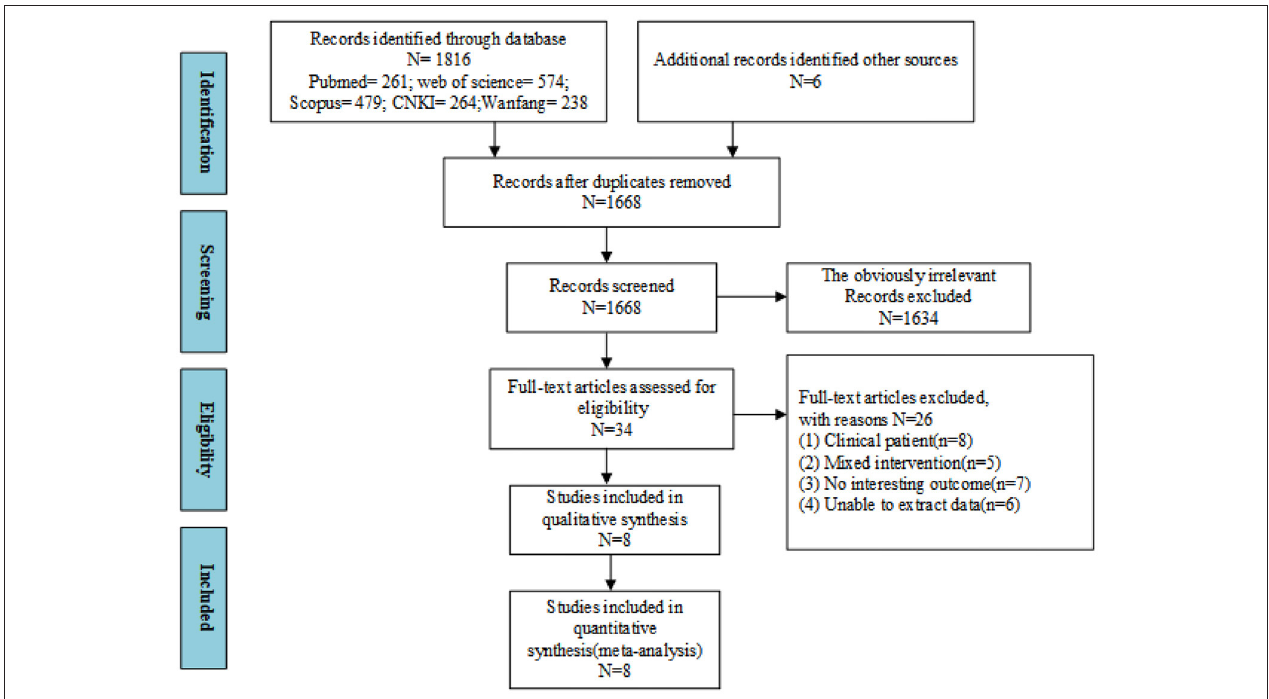
FIGURE 1 | The detailed process of trial